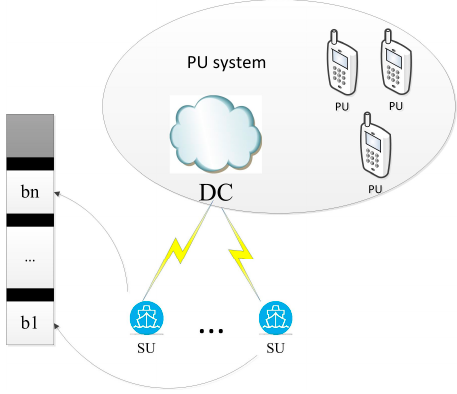
Figure 2. Enhanced dynamic spectrum allocation algorithm (EDSAA) model.